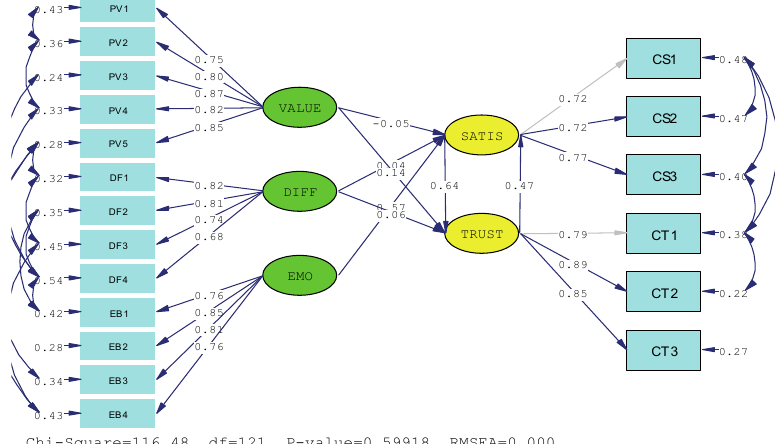
Fig. 2 . Modified structural model’s path diagram (standardized